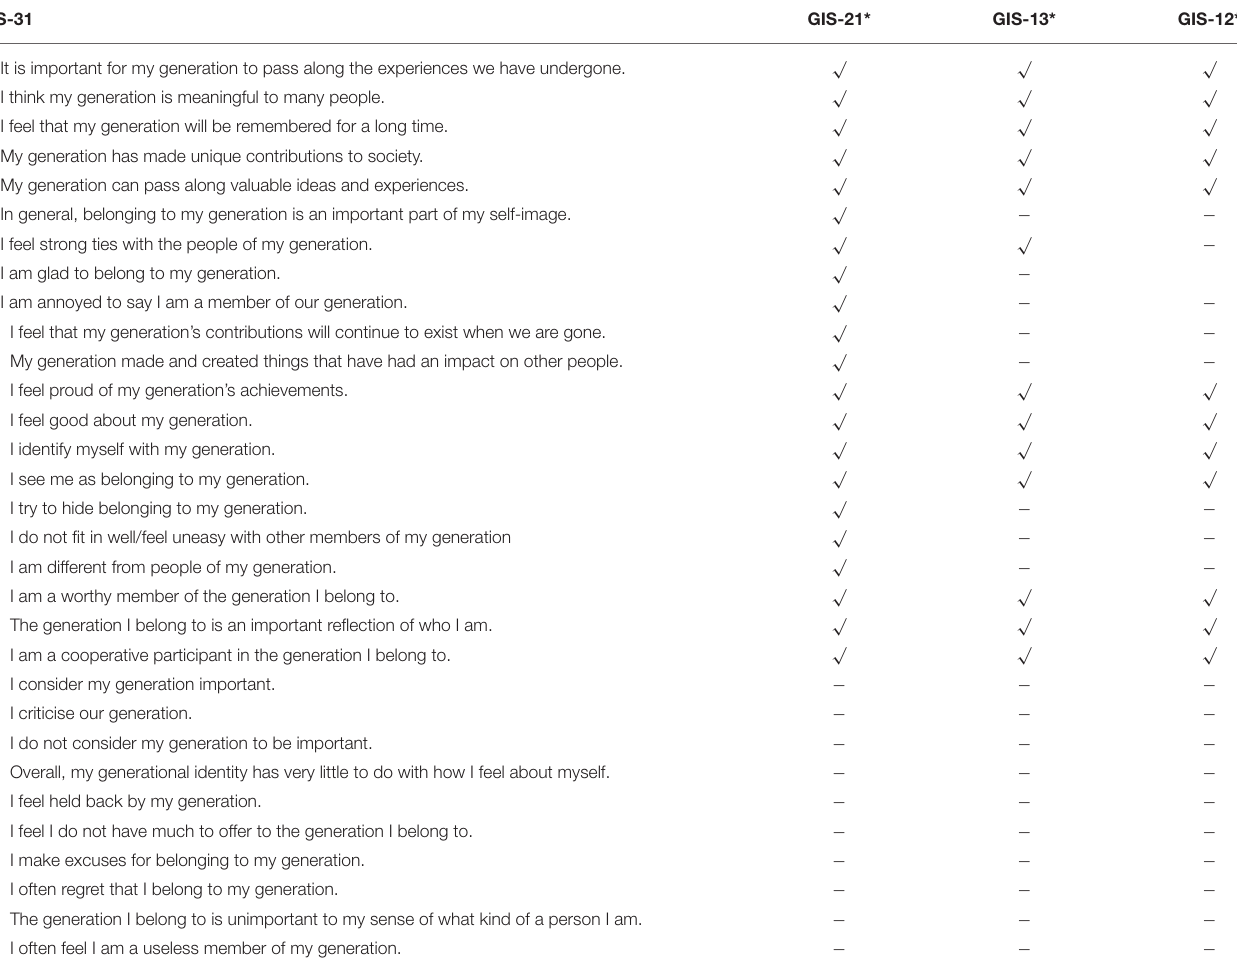
TABLE 1 | List of Items for Generational Identity